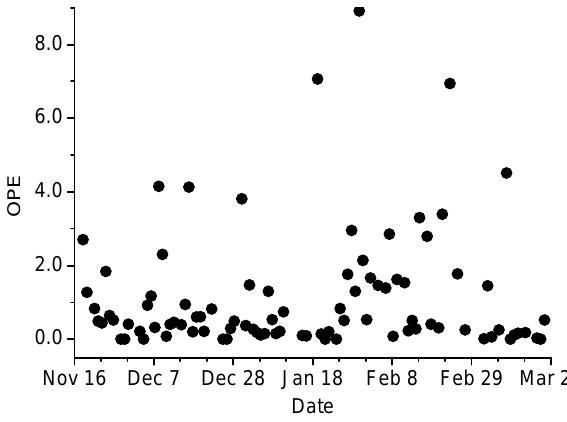
Fig. 10 Time series of daily OPEx during the observation period for the CMA site. Daily Fig. 10. Time series of daily OPEx during the observation period OPEx values are calculated using the NO z and O x data between 7:00-11:00. The OPEx for the CMA site. Daily OPEx values are calculated using the NO z and O x data between 07:00–11:00LT. The OPEx values are in the values are in the range of 0-8.9 (ppb/ppb) with the mean(±1 σ ) and median values being range of 0–8.9 (ppbppb − 1 ) with the mean( ± 1 σ) and median values being 1.1( ± 1.6) and 0.5 (ppbppb − 1 ), respectively. 1.1(±1.6) and 0.5 (ppb/ppb), respectively. 5